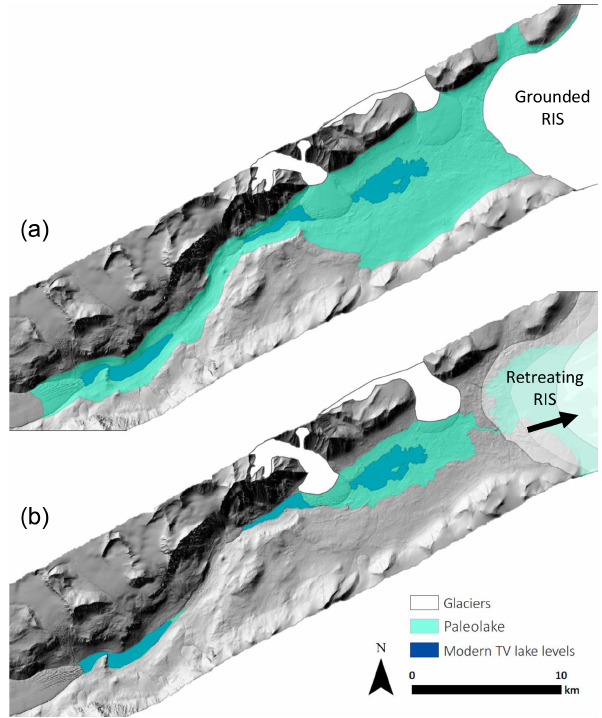
Figure 3. (a) Glacial Lake Washburn extending up Taylor Valley (300ma.s.l.). Extent of grounded Ross Ice Sheet is estimated from maps of Ross Sea drift moraine locations (Hall and Denton, 2000); (b) Holocene extent of paleolake, limited by 81ma.s.l. sill between Lake Fryxell and the McMurdo Sound. Modern-day lake levels shown in dark blue. Extent of alpine glaciers (Canada and Com- monwealth glaciers in white) is estimated. The DEM (1m resolu- tion) is from 2014–15 lidar survey, accessed via OpenTopography (Fountain et al.,